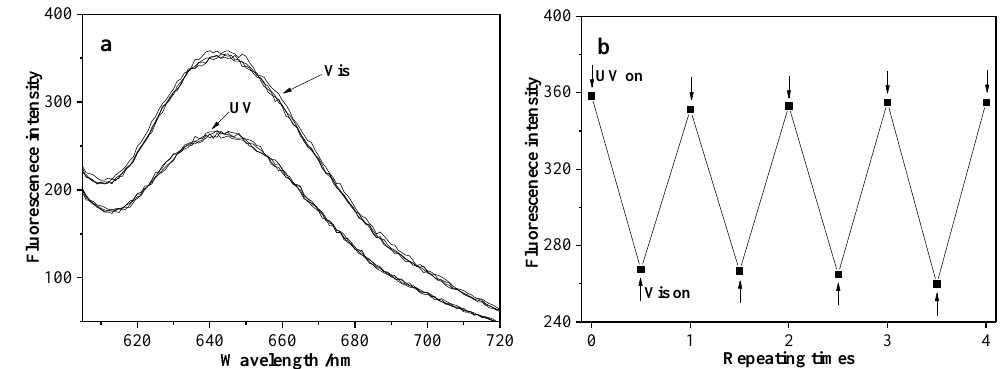
Figure 11. Fluorescence spectra of NR-S3 micellar solution under alternating UV and visible light irradiation to the photostationary state four times ( a ) and evolution of their maximum fluorescence intensity ( b ).